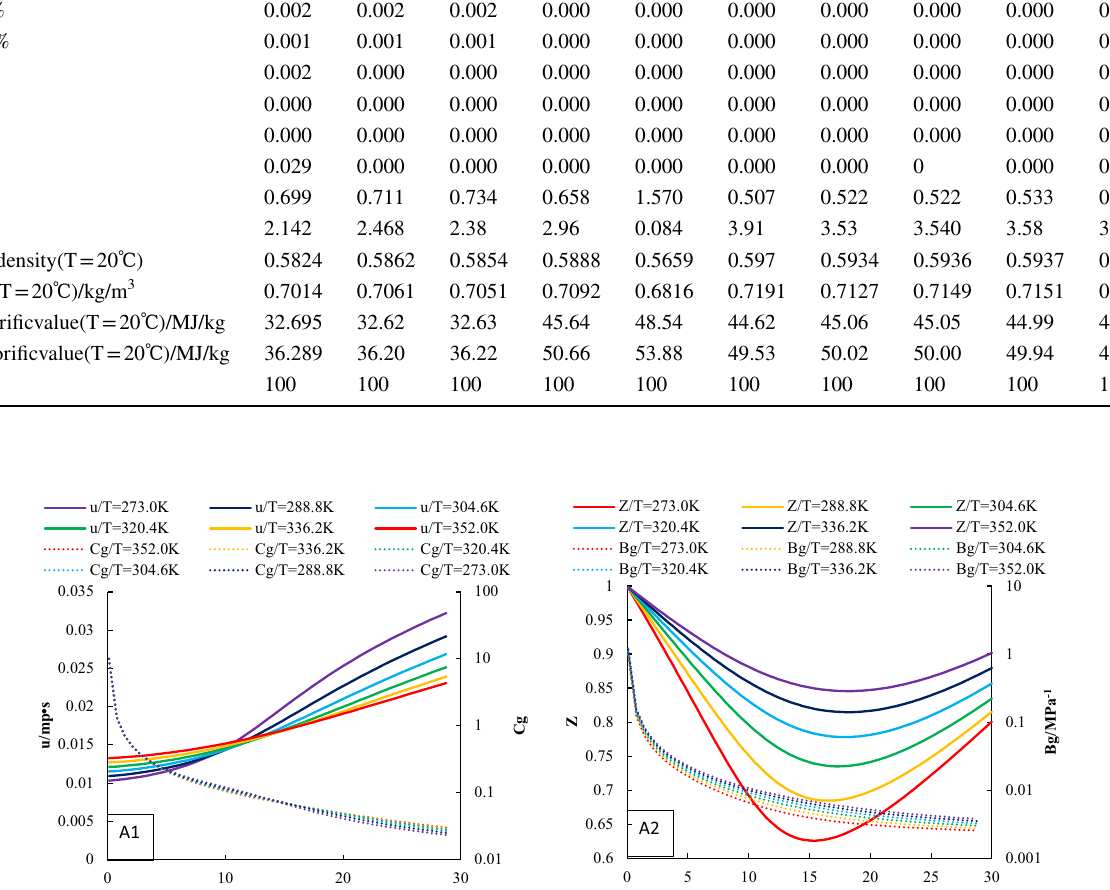
g curve of natural gas; A2: P–Z curve of natural gas and P – B g curve